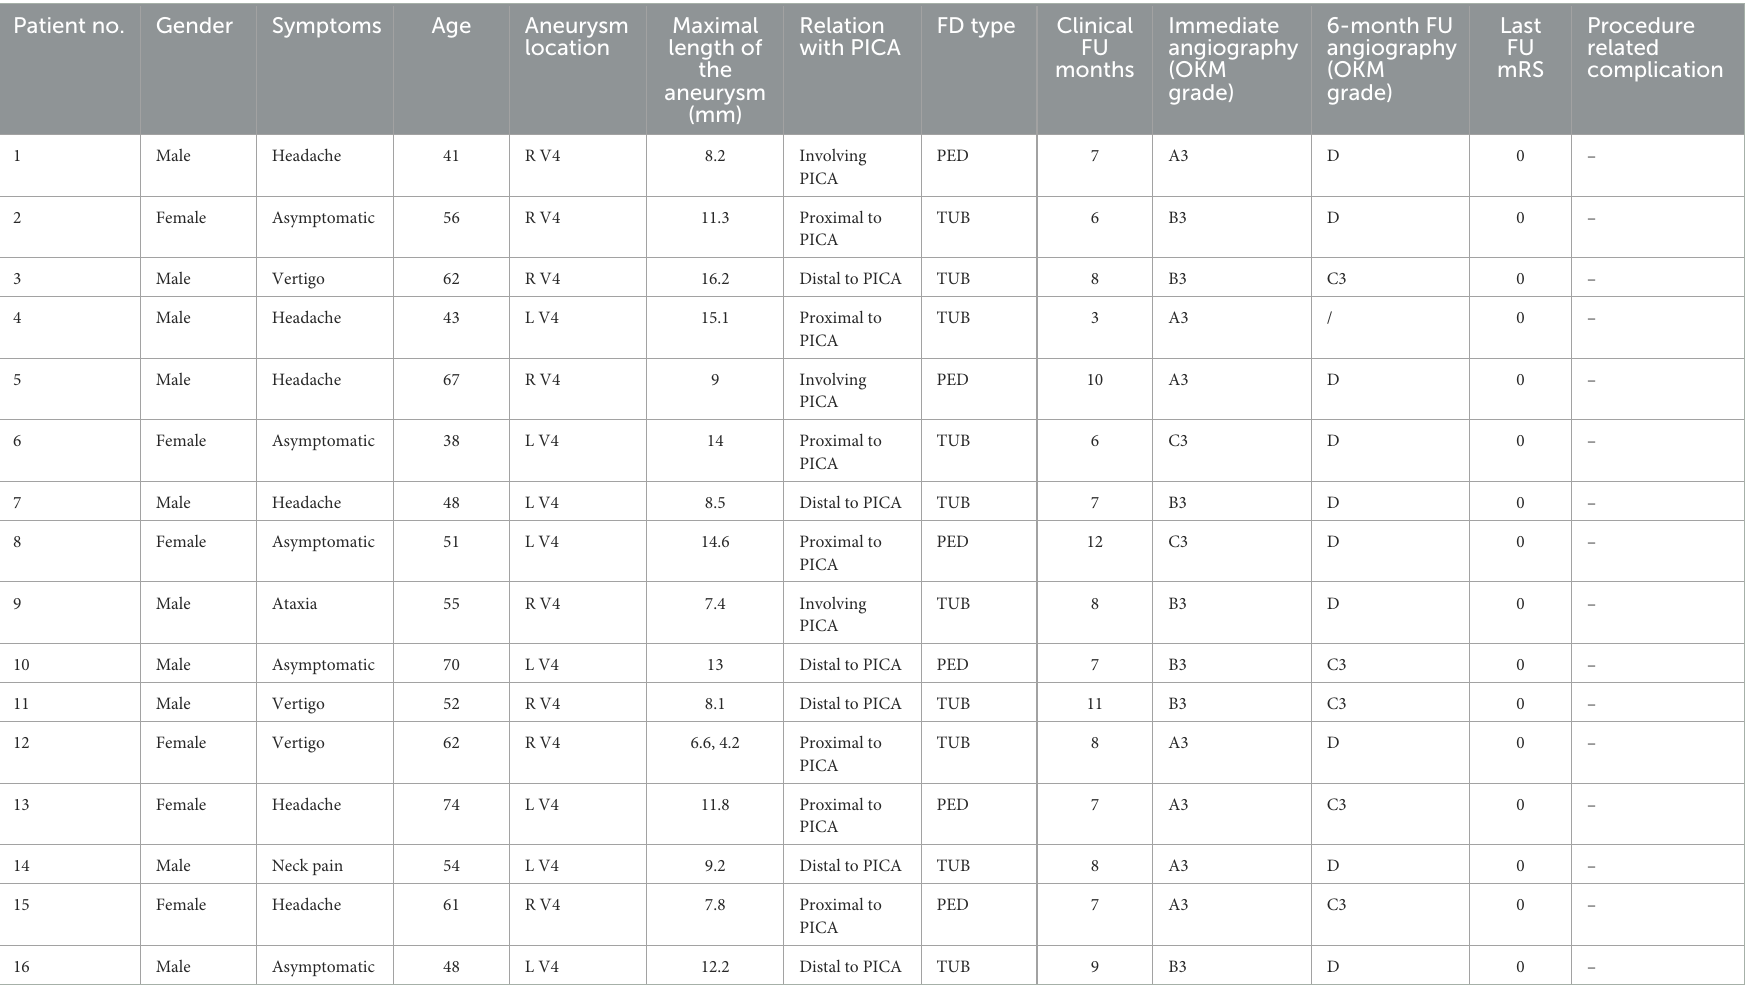
TABLE 1 Clinical features of 16 patients with unruptured vertebral artery dissecting aneurysms and radiologic and clinical follow-up outcomes after flow diversion deployment. Patient